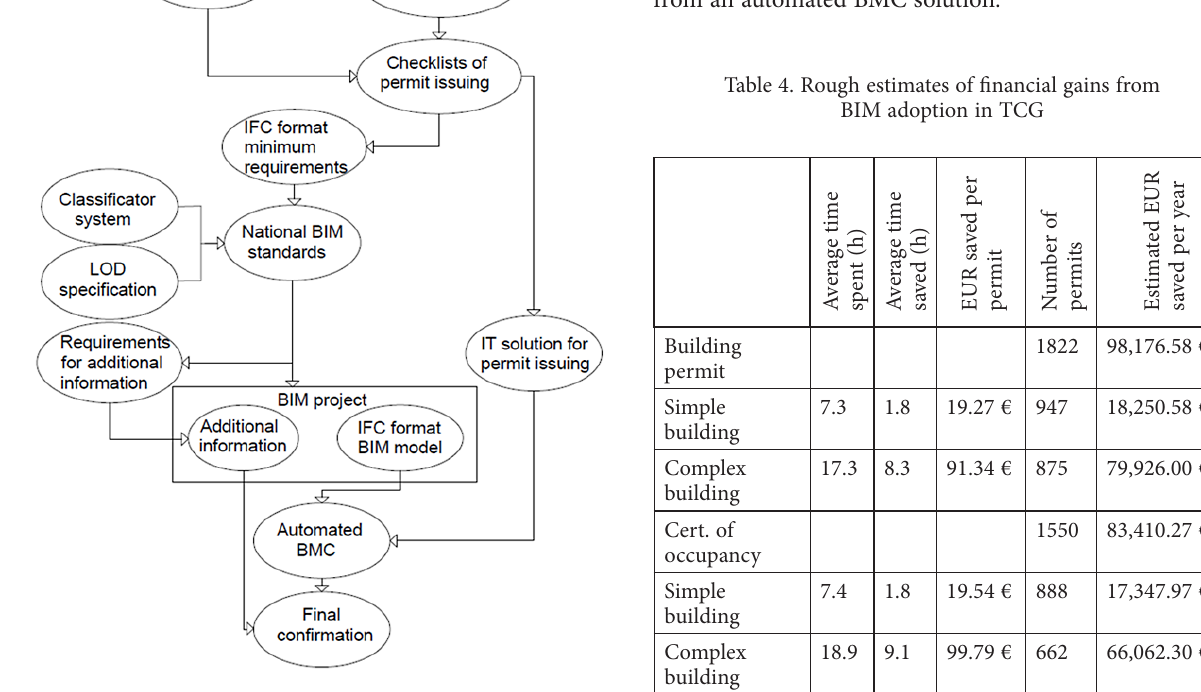
Figure 3. New business model of TCG for BIM-based permit